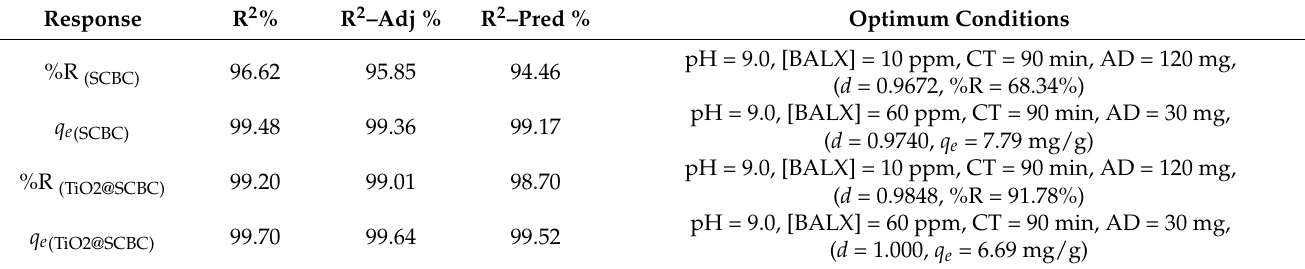
Table 5. Regression models and the assessment parameters, and the optimum conditions.